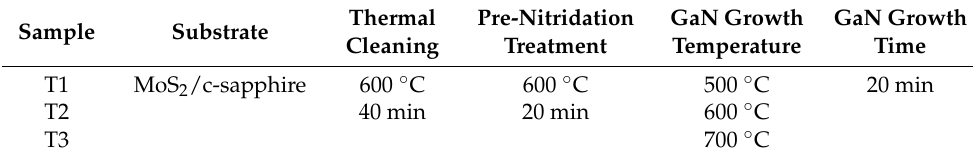
Table 1. Growth parameters of vdW epitaxial GaN thin films on layered 2D MoS 2 . Sample